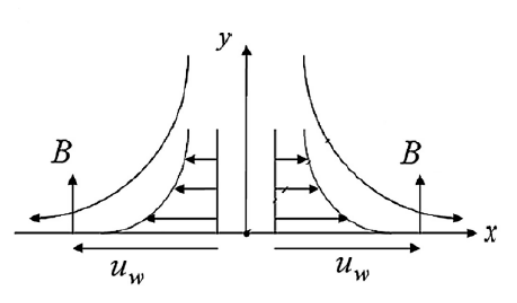
Figure 1. Configuration of